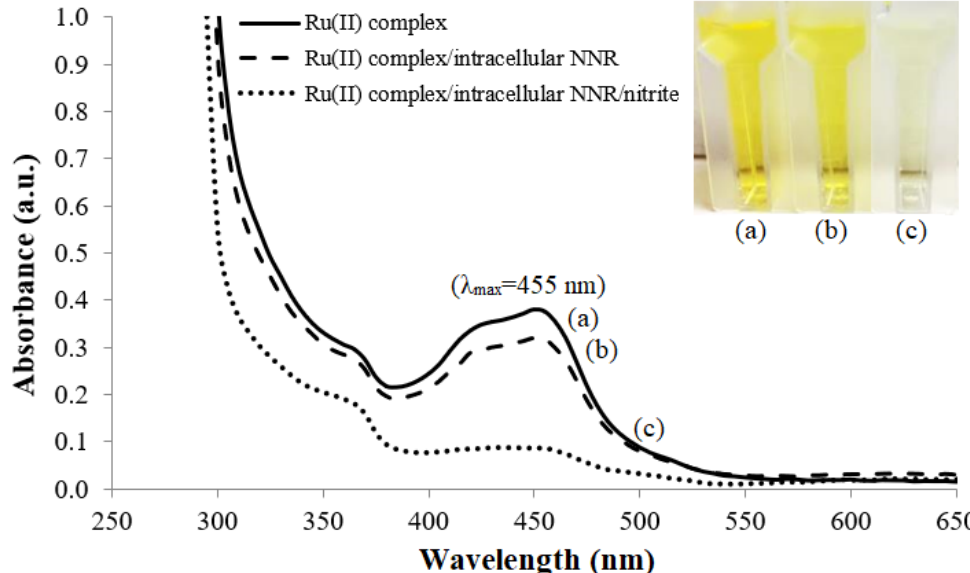
Figure 2 . The UV-vis spectra of absorption peak responses at 455 nm for (a) 0.01 mg mL − 1 Ru(II) complex solution, (b) free whole cell R. planticola and 0.048 mM NAD(P)H co-substrate in the 0.01 complex solution, ( b ) free whole cell R. planticola and 0.048 mM NAD(P)H co-substrate in the mg mL − 1 Ru(II) complex solution before and (c) after reaction with nitrite in 0.1 M K-phosphate 0.01 mg mL − 1 Ru(II) complex solution before and ( c ) after reaction with nitrite in 0.1 M K-phosphate buffer at pH 7.4. buffer at pH